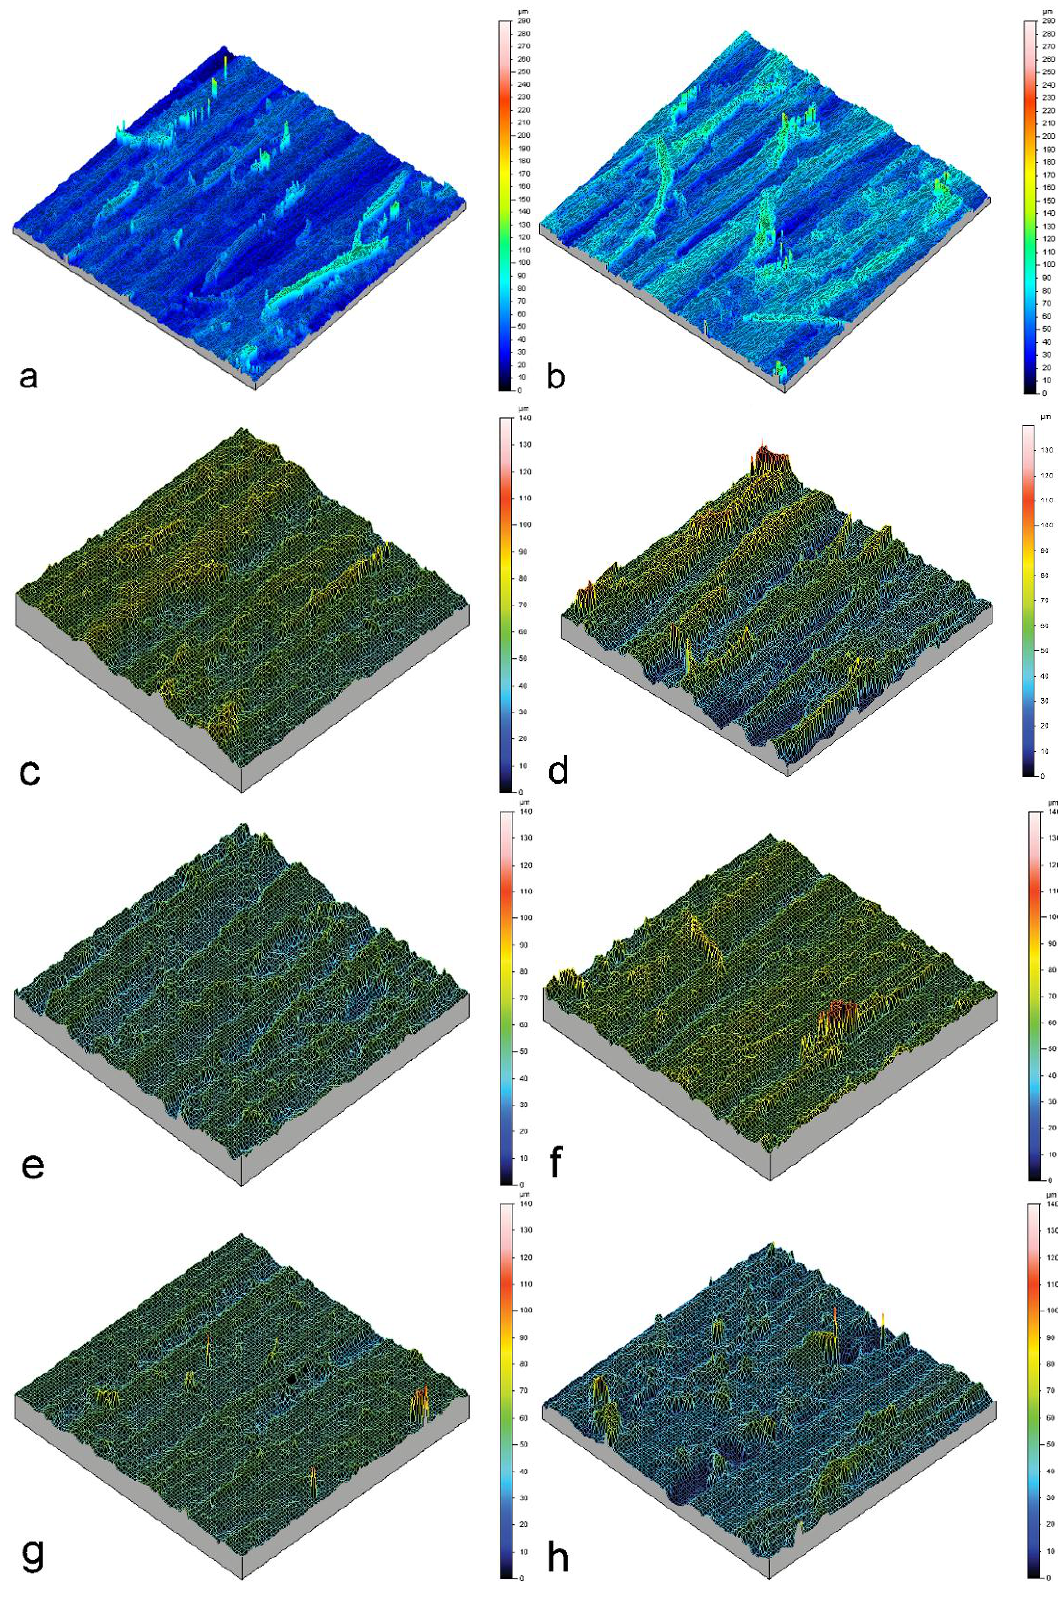
Figure 3. Confocal profilometry images of sanded surfaces before ( a , c , e , g ) and after grain raising ( b , d , f , h ): ( a , b ) balsa; ( c , d ) western red cedar; ( e , f ) black cherry; ( g , h ) sugar maple.